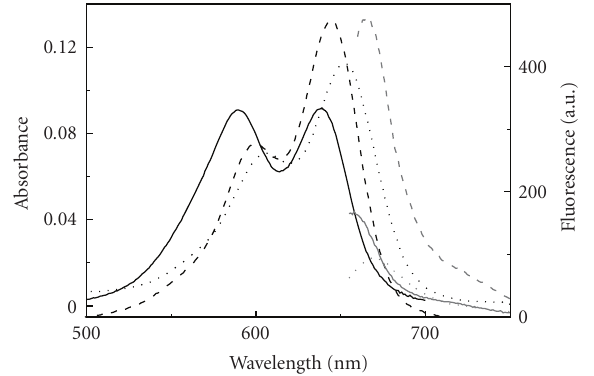
Figure 5: Absorption (black lines) and fluorescence spectra (grey lines) of PAH-Cy5 A (1: 840) in various solvent: DMF (dashed line), H 2 O (solid line) and PSS solution (C PSS = 5mg/mL) (dotted line). (Monomer ratio between PAH and PSS is 1:12.) The fluorescence spectra are taken with λ ex = 638nm and a slit width of 5/10nm.